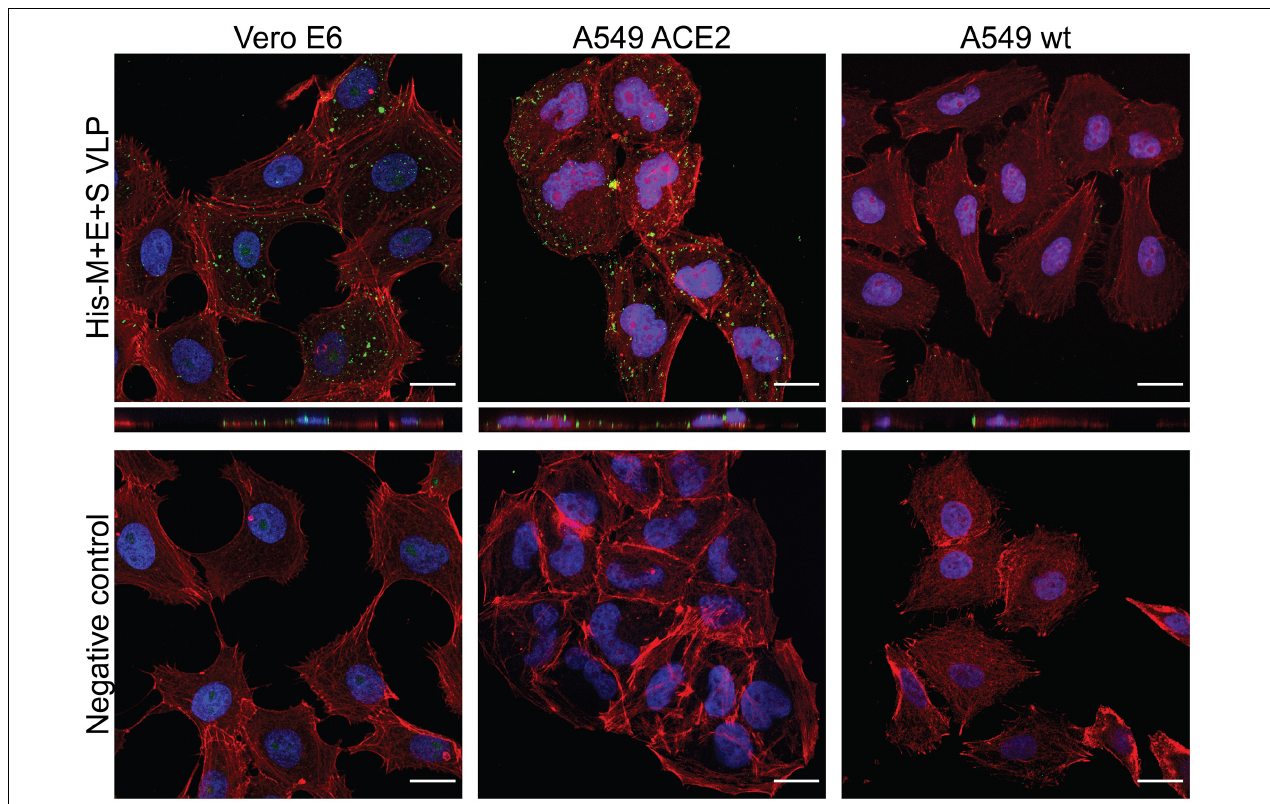
FIGURE 3 | SARS-CoV-2 VLP entry to target cells. His-M + E + S VLPs were incubated with Vero cells (left panel), A549 expressing ACE2 receptor cells (middle panel), and wild-type A549 cells (right panel). VLP entry was visualized by M protein (in Vero cells) or S protein (in A549 cells) detection with respective antibodies (shown in green); nuclei are stained with DAPI (blue), and actin filaments are stained with fluorescently labeled phalloidin (shown in red). Controls are images of respective cells incubated with mock samples (collected from uninfected insect cells) and stained identically as cells incubated with VLPs. SARS-CoV-2, severe acute respiratory syndrome coronavirus 2; VLP, virus-like particle; ACE2, angiotensin-converting enzyme